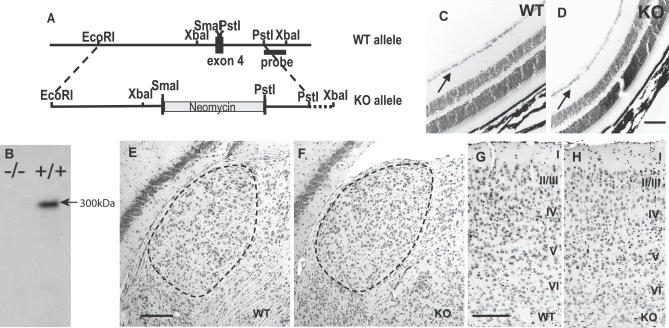
Visual Structures Have Normal Appearance in Ten_m3 KO Mice(A) Schematic diagram illustrating the strategy used to generate Ten_m3 KO mice.(B) Western blot stained with an antibody for Ten_m3. A prominent band of approximately 300 kDa corresponding to Ten_m3 is visible in the WT (+/+) mouse. This is absent in the KO(−/−) mouse.(C–H) Nissl-stained sections through retina (C) and (D), dLGN (E) and (F), and cortical area 17 (G) and (H) from WT mice (C), (E), and (G) and Ten_m3 KO mice (D), (F), and (H). No differences in size or cellular density of these structures can be discerned. Lamination of the retina and visual cortex also appears normal. The RGC layer is indicated by arrows in (C) and (D), and cortical layers are indicated with Roman numerals in (G) and (H). The borders of the dLGN are indicated by a dotted line in (E) and (F). Scale bar in (D) indicates 100 μm, which applies also to (C); scale bars in (E) and (G) indicate 200 μm, which also apply to (F) and (H), respectively.